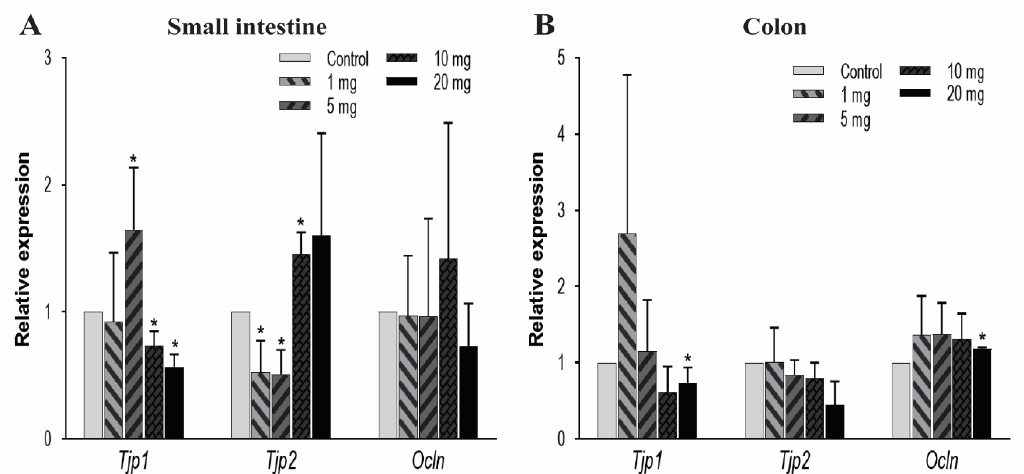
Figure 4. Effect of PFOA on the expression levels of tight junction genes Tjps and Ocln in intestinal tissues of CD1 mice. Mice were treated with control (0.5% Tween-20 in water) or 1–20 mg / kg / day PFOA for 10 days. ( A ) Change in the mRNA expression of Tjp1, Tjp2, and Ocln genes in the small intestine; ( B ) change in mRNA expression of Tjp1, Tjp2 , and Ocln genes in the colon. Statistical values were considered significant at p -value ≤ 0.05 (denoted by “*”) and less significant at p -value > 0.05.